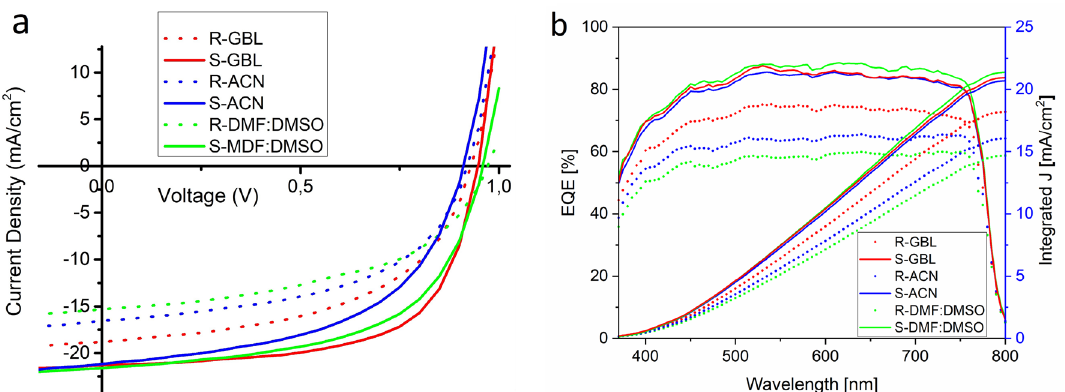
Figure 3. ( a ) Comparison of IV results for solvent types and their planar reference PSCs and ( b ) IPCE results for each PSCs. (R and S refer to reference PSCs and Sepiolite included PSCs respectively. GBL, ACN and DMF:DMSO are solvents used for perovskite layer